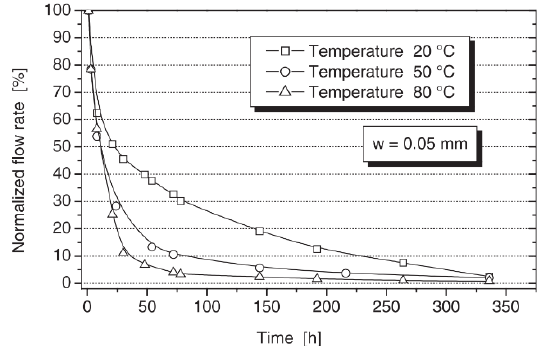
Figure 7. Decrease in the normalized flow rate because of the self-healing of the crack at various temperatures, a pressure gradient of 1 MPa/m, and a crack width of 0.05 mm. Reprint with the permission from ref.[61]. Copyright 2022 Elsevier.